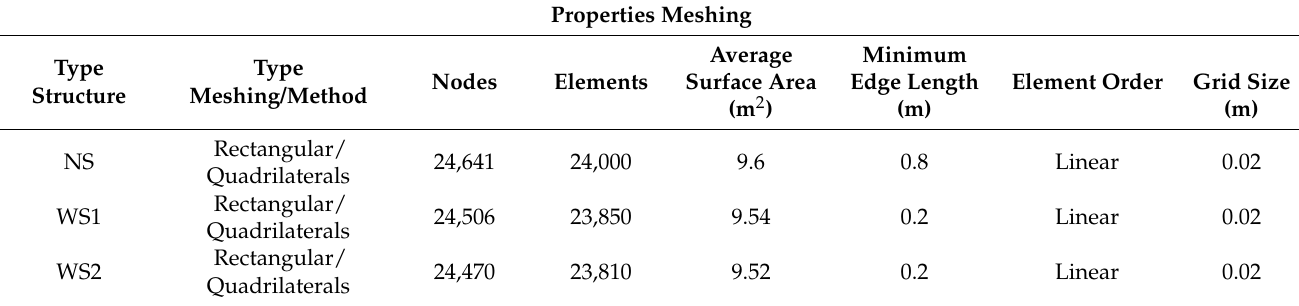
Table 1. Generated mesh